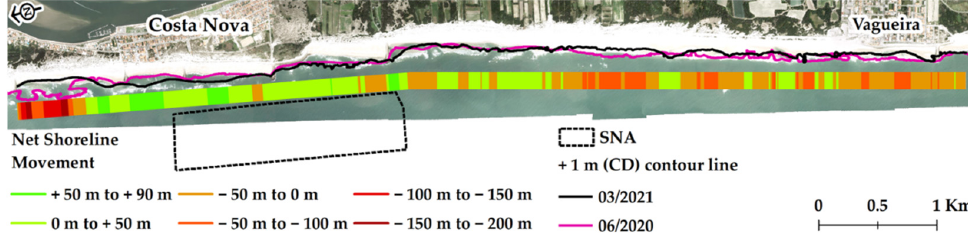
Figure 11. Horizontal displacement of the + 1 m (CD) contour line and its variation in terms of advance or retreat.